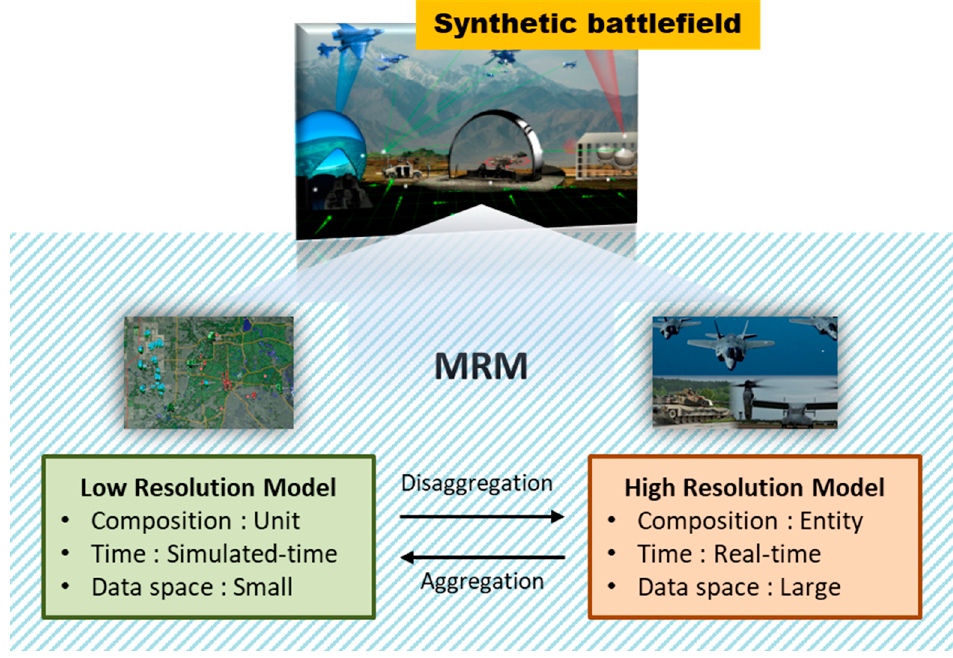
Figure 1. Concept of Multi-Resolution Modeling.